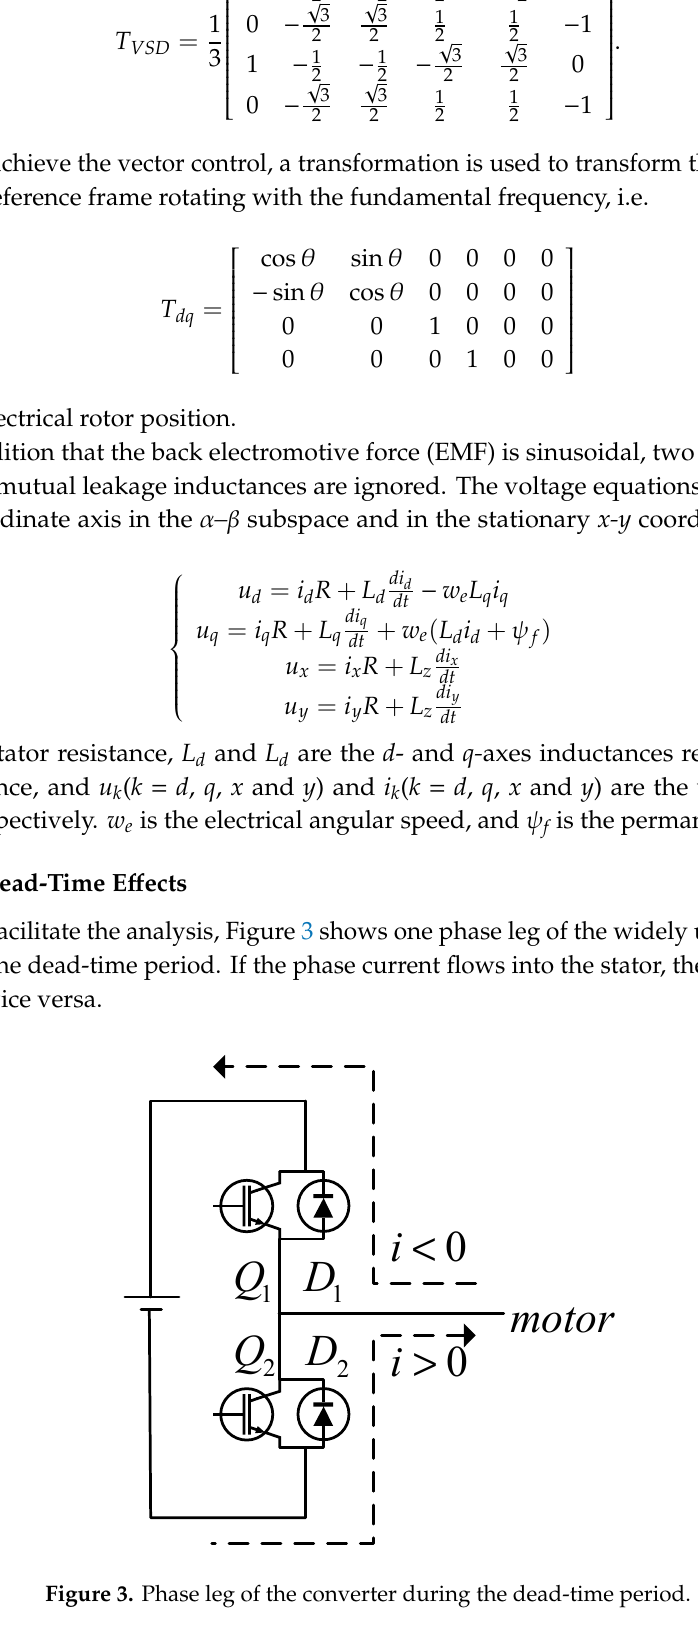
Figure 3. Phase leg of the converter during the dead-time period.